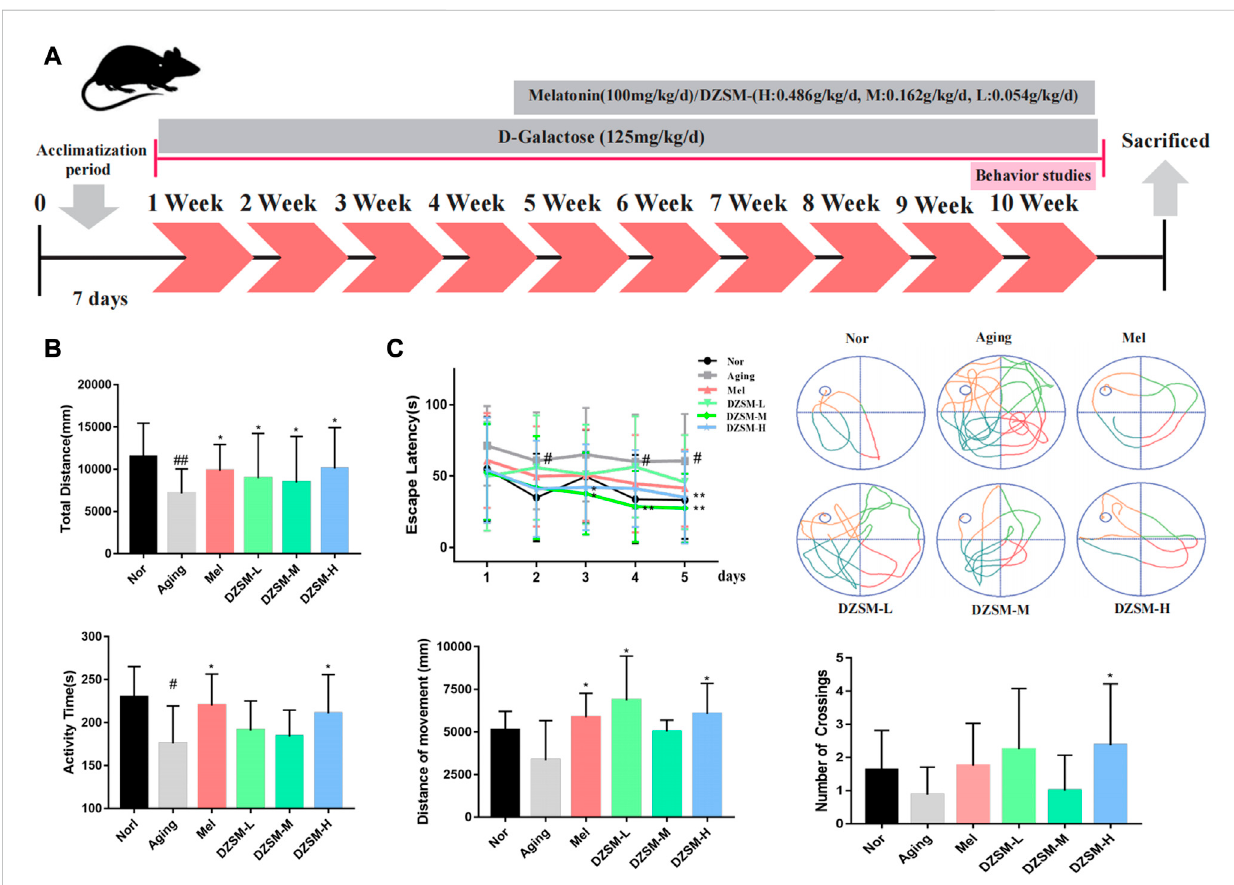
FIGURE 1 Experimental design and behavioral analysis. (A) Experimental design for medication treatment in C57BL/6 mice and behavioral analysis; (B) Open fi eld task: a. total movement distance, b. activity time; (C) Morris water maze: a. latency to platform in the 5-day training phase, b. movement tracking in the positioning navigation phase, c. movement distance in target quadrant, d. number of platform crossings. (Compared with the Nor group: # p < 0.05, ## p < 0.01; compared with the Aging group: * p < 0.05, ** p < 0.01, n =